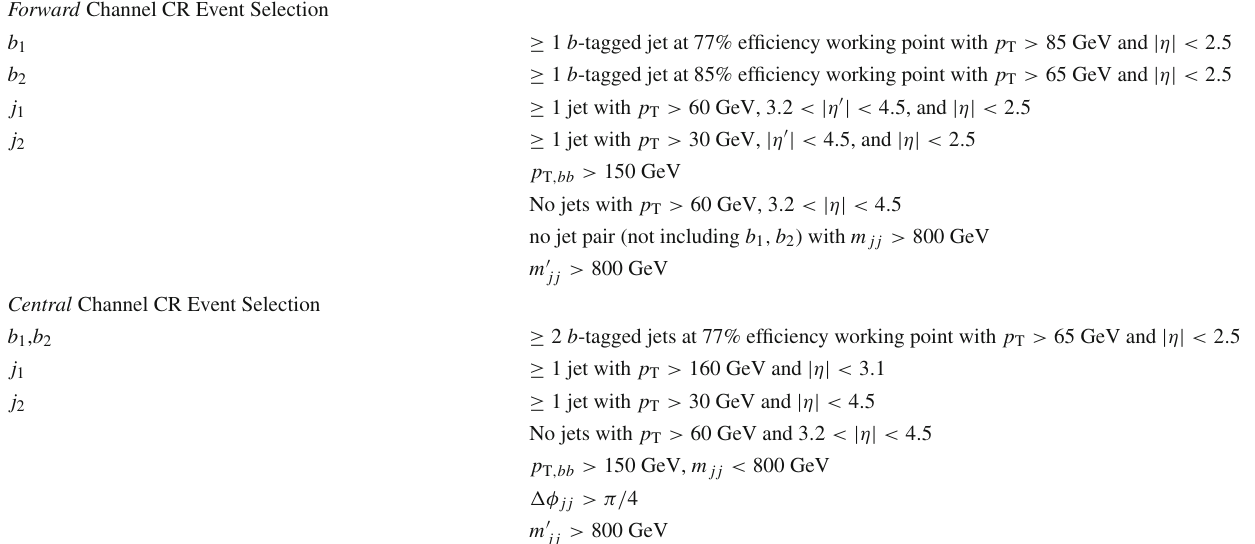
and m (cid:7) refer to the η and m jj of the VBF jets after the jj